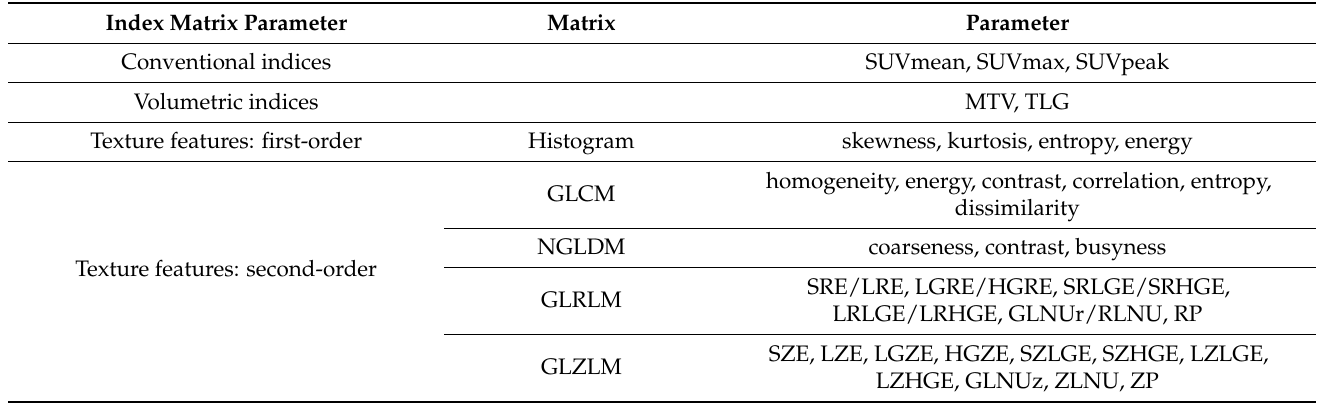
Table 1. Parameters evaluated included conventional and volumetric indices and texture features. Index Matrix